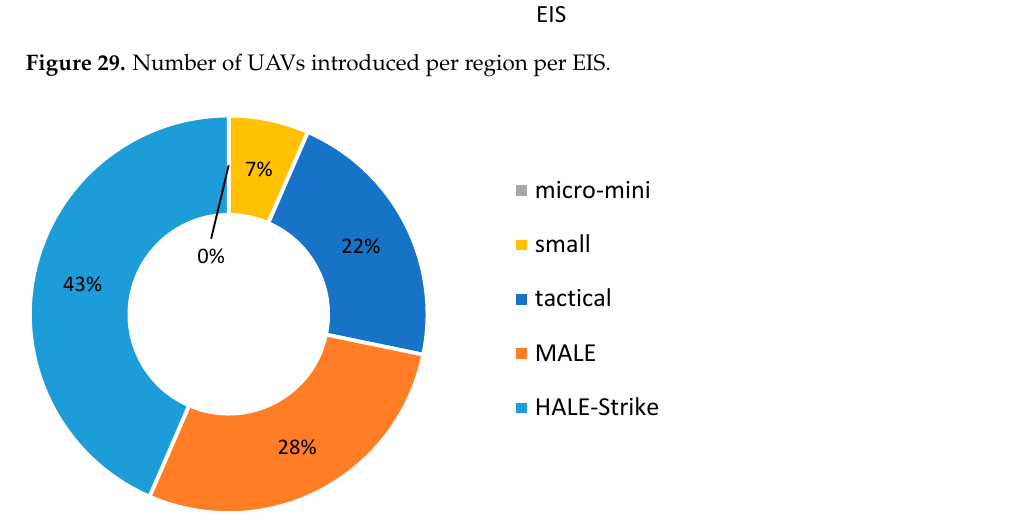
Figure 30. UAVs equipped with satellite communication systems per NATO category.